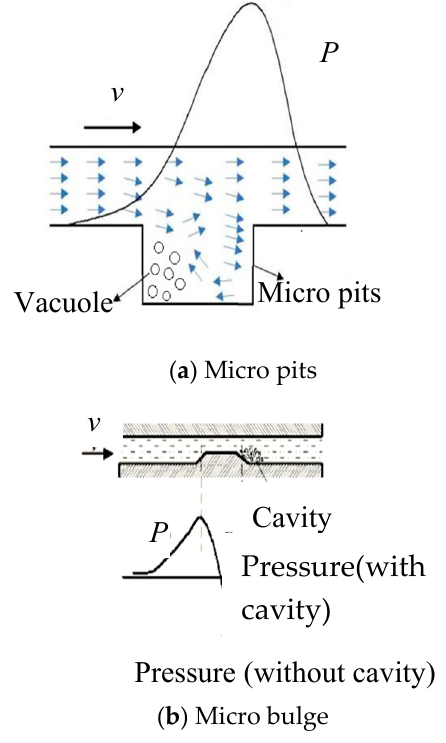
Figure 1. Dynamic pressure lubrication.